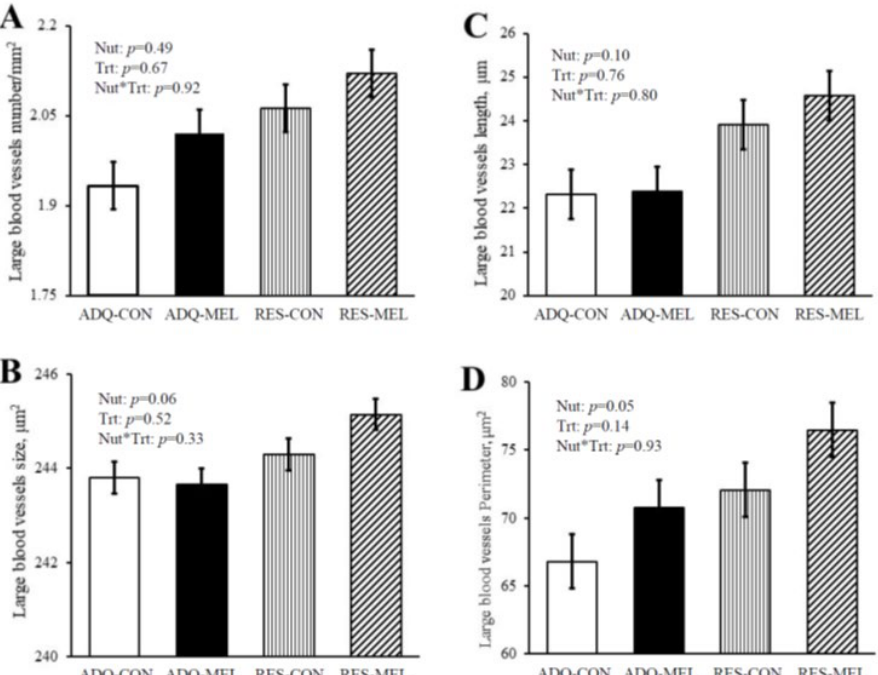
Figure 2. Large blood vessel characteristic of 8-month-old fetuses. ( A ) Large blood vessel numbers per tissue area, ( B ) large blood vessel size, ( C ) large blood vessel diameter length, and ( D ) large blood vessel perimeter. Values are means ± SE.